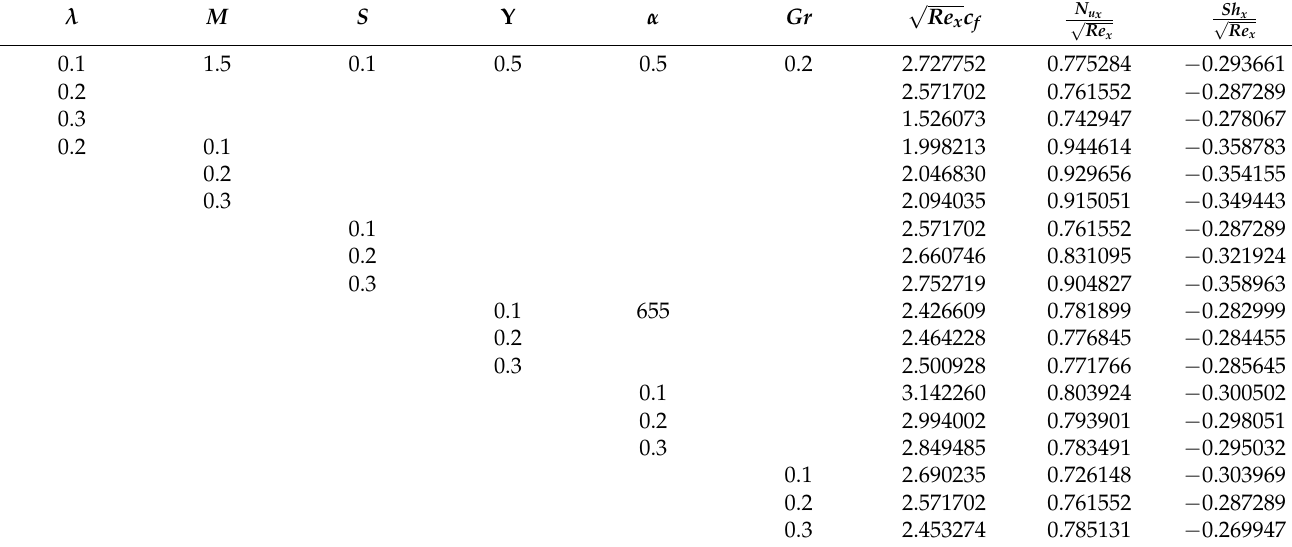
Table 2. Numerical values of c f , Nu x against several values of λ , S , Y , α , Gr , and M